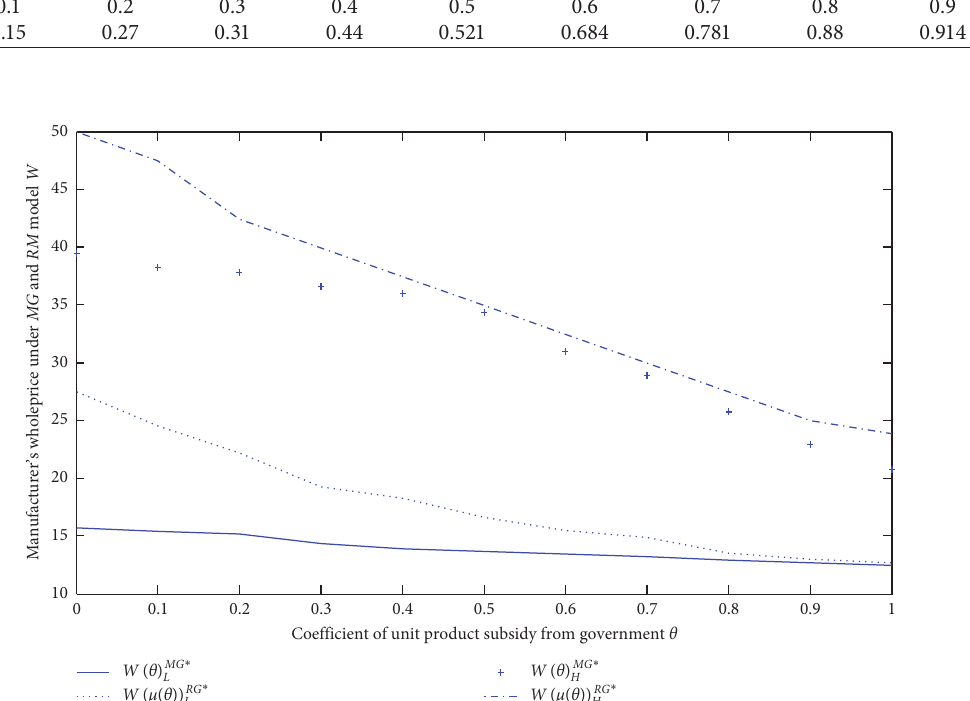
Figure 2: The impact of different government subsidy coefficients on the manufacturer’s wholesale price under two models.